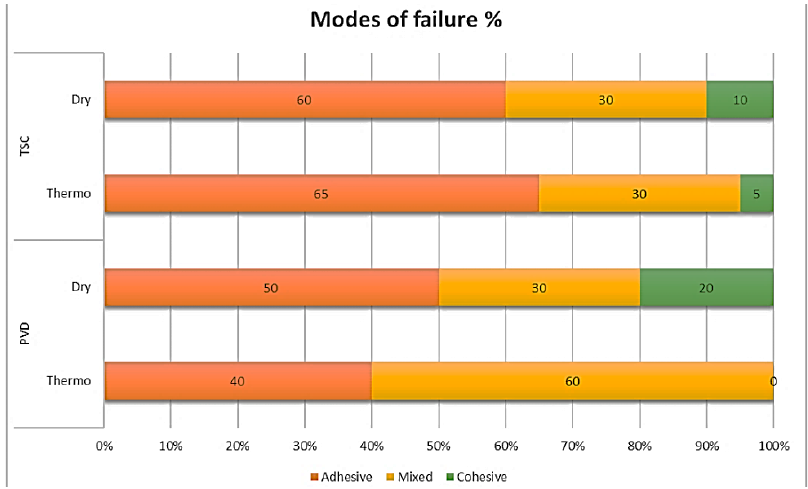
Figure 4. Different modes of failure of all tested zirconia samples .